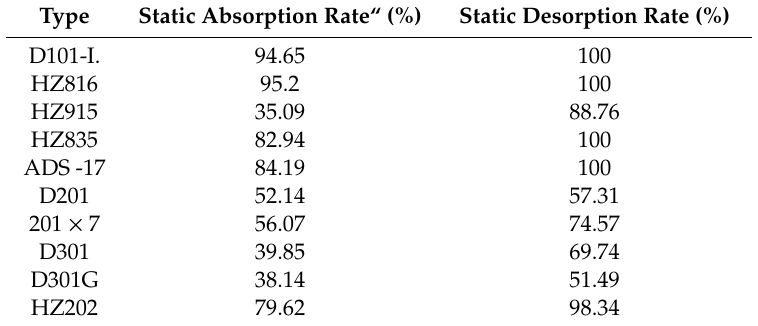
Table 1. The ratios of adsorption and desorption capsaicinoids on macroporous resins in static state. Type Static Absorption Rate“